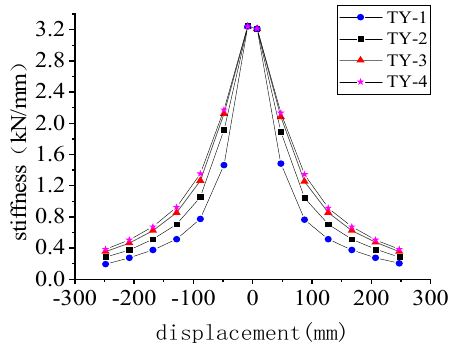
Figure 20. Stiffness degradation curve of TY specimen.